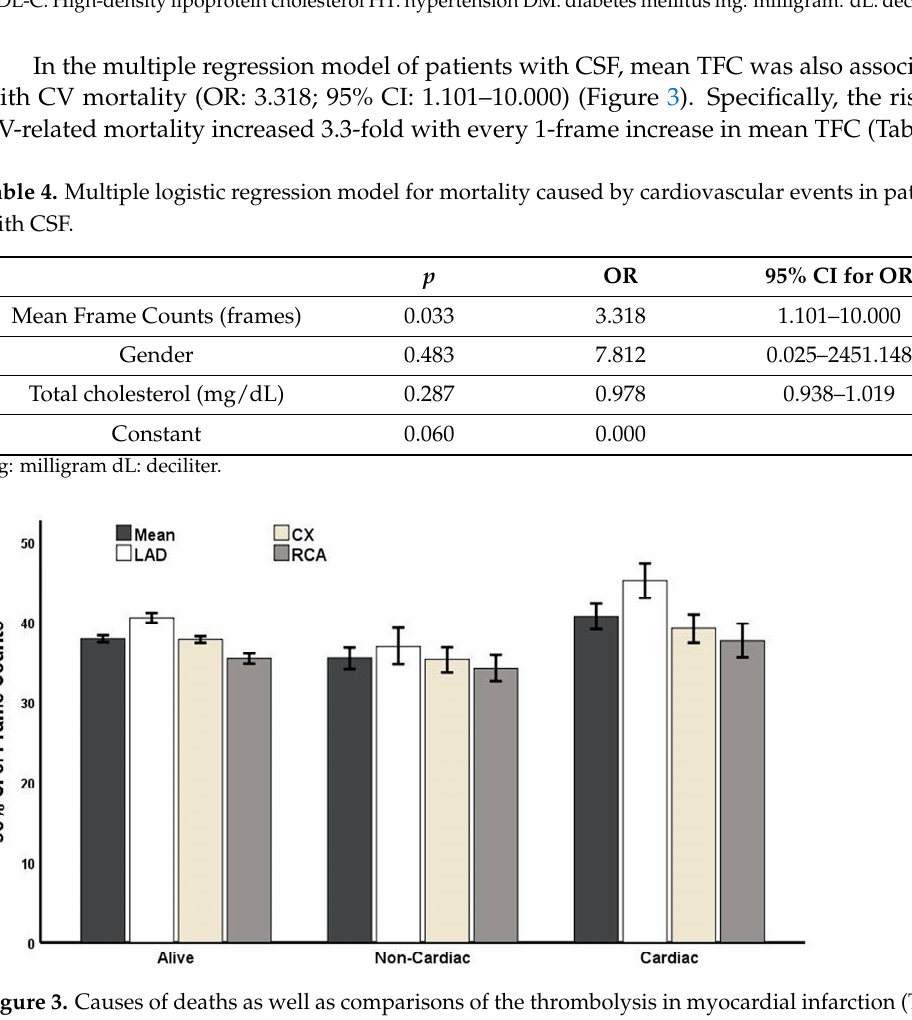
Figure 3. Causes of deaths as well as comparisons of the thrombolysis in myocardial infarction (TIMI) frame counts of surviving patients and those who experienced cardiovascular or non-cardiovascular death after 10 years of